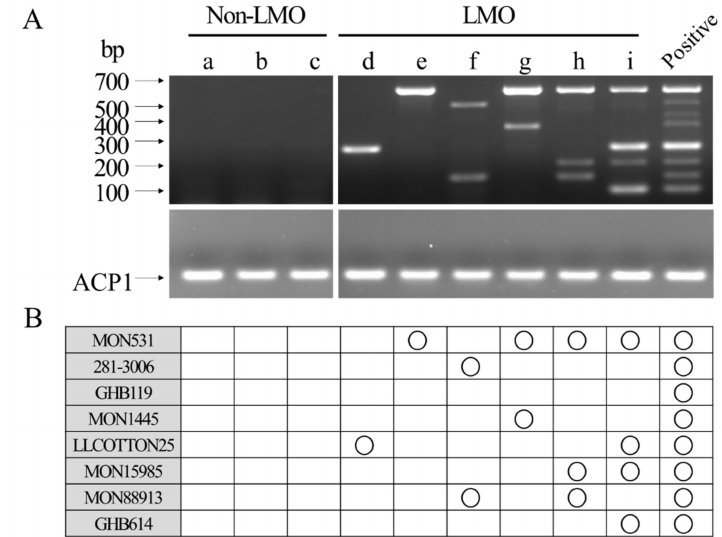
Figure 5. Application of the multiplex PCR method for the collected, candidate LM cotton samples by LMO monitoring. ( A ) Analysis of multiplex PCR. ( B ) Determination of events confirmed by nucleotide sequencing analysis. The circles indicate detected events (area a: Non-LMO; area b: Non-LMO; area c: Non-LMO; area d: LLCOTTON25; area e: MON531; area f: 281-3006 × MON88913; area g: MON531 × MON1445; area h: MON88913 × MON15985; area i: MON15985 × MON531 × LLCOTTON25 × GHB614; line p: Eight cotton events). If MON15985 and MON531 were detected at the same time, they were considered